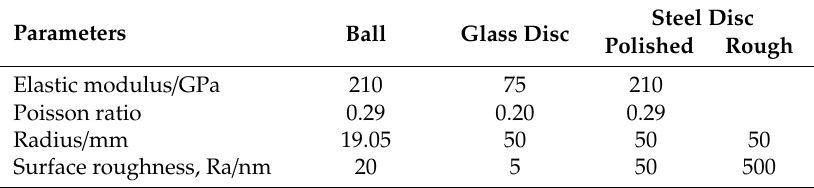
Table 3. Main characteristics of the ball and